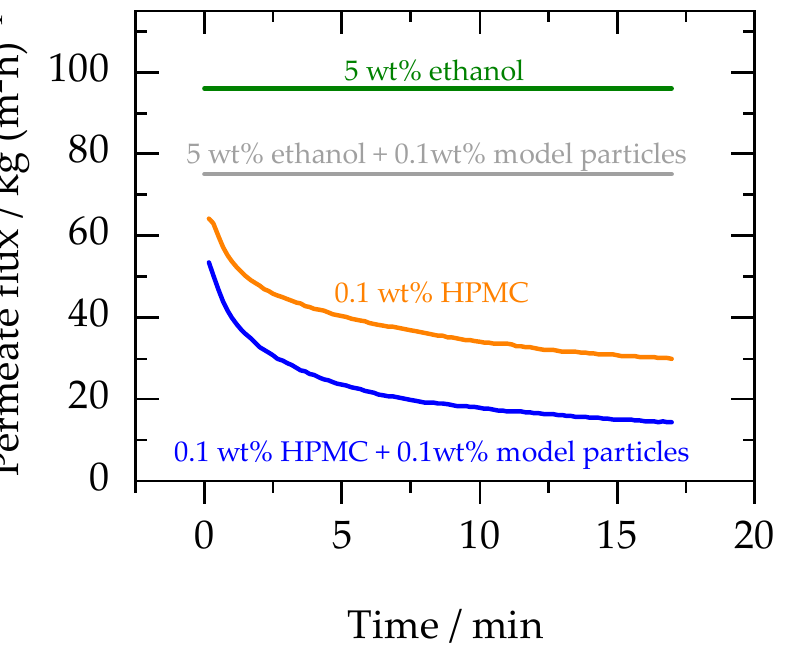
Figure 4. Green line indicates the permeate flux profile for the diafiltration with an aqueous feed containing a 5 wt% ethanol solution. The grey line indicates the permeate flux profile of an aqueous feed containing 0.1 wt% model particles and 5 wt% ethanol. Orange line represents the permeate flux profile for the feed with 0.1 wt% HPMC E3 solution (in water), and blue line shows the permeate flux profile for the feed consisting of 0.1 wt% model particles and 0.1 wt% HPMC E3 in water. Experiments were performed at 30 bar and 25 °C.